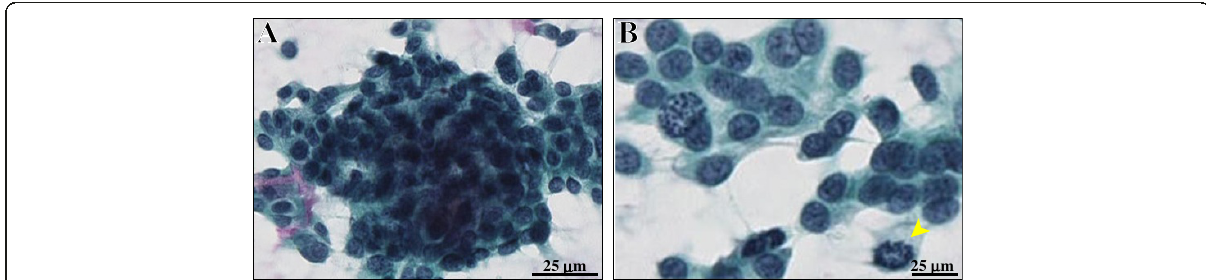
Figure 1 Cytomorphologic examination of the bronchial brushing cytology specimens. ( A ) The cytology specimens were consisted of many clusters of cohesive and sheet-like or three-dimensional tumor cells and a small number of individual tumor cells without necrotic or hemorrhagic backgrounds (Papanicolaou stains). Bar = 25 μ m. ( B ) Those malignant cells showed small to medium-sized (12 to 20 μ m in diameter), relatively uniform, and round to oval with mild pleomorphism and had relatively scanty cytoplasm. Additionally, the nuclei were hyperchromatic, predominantly in a coarsely granular chromatin pattern, and had inconspicuous nucleoli but mitotic figures (arrowhead) (Papanicolaou stains). Rosettes were absent. Bar = 25 μ